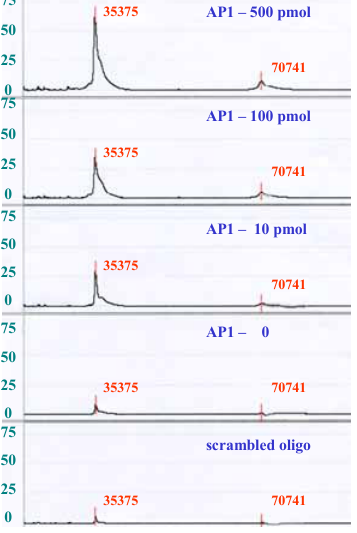
Figure 1. SELDI spectra of varying concentrations of duplexed AP-1 oligonucleotide and scrambled oligonucleotide sequence following incubation with 42 pmol of recombinant c-Jun protein. Protein signal height is represented on the y-axis and MW/z on the x-axis. Peak at 70,741 is a dimer of the 35,375 MW c-Jun protein.